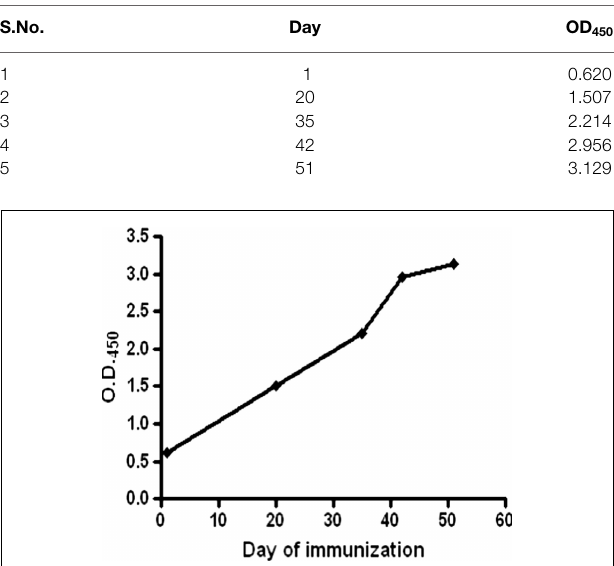
TABLE 2 | Absorbance values observed in ELISA for estimation of anti-HA antibodies in mice sera, after each immunization with influenza A/New Caledonia/20/99(H1N1) virus .